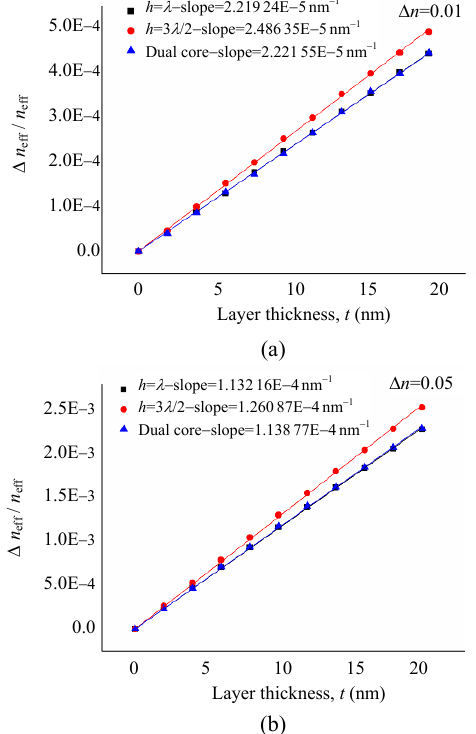
Fig. 9 Relative change in the effective refractive index, and consequently in the resonant wavelength, as function of the thickness t of the bio-layer, when the change in its refractive index is